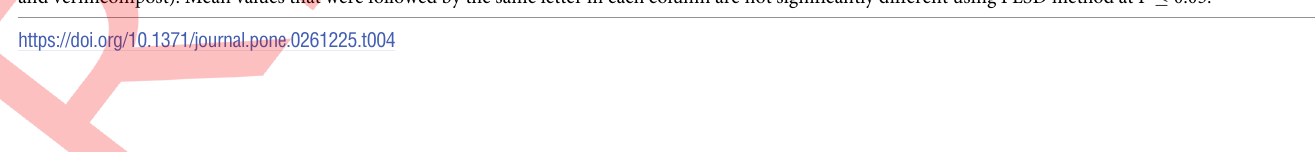
Where I w (full irrigation), I s (limited irrigation), F c (no fertilizer), F m (mycorrhiza inoculation), F v (vermicompost application), and F m+v (combination of mycorrhiza and vermicompost). Mean values that were followed by the same letter in each column are not significantly different using PLSD method at P �